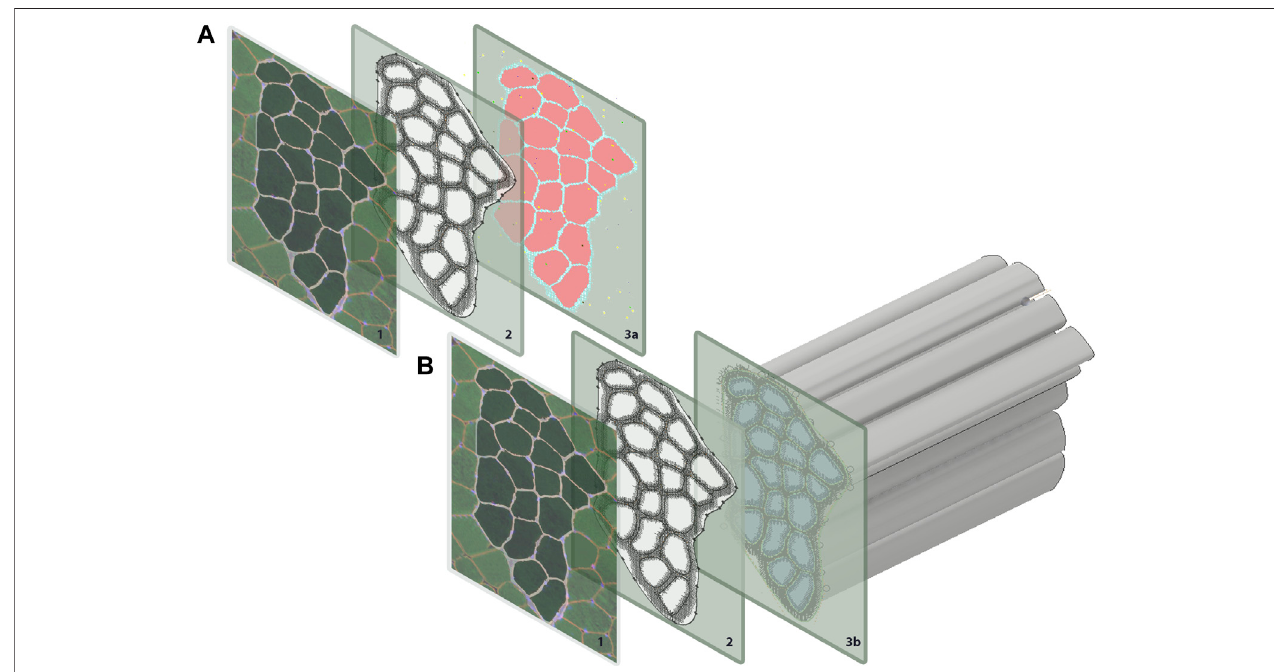
FIGURE 1 | Geometry for both the agent-based models and FE models were generated from a single histological section. The coordinates for each pixel were extracted in MATLAB and used to recreate (A) pixels on ABM grid, and (B) to extrude muscle fi bers for the FE models.